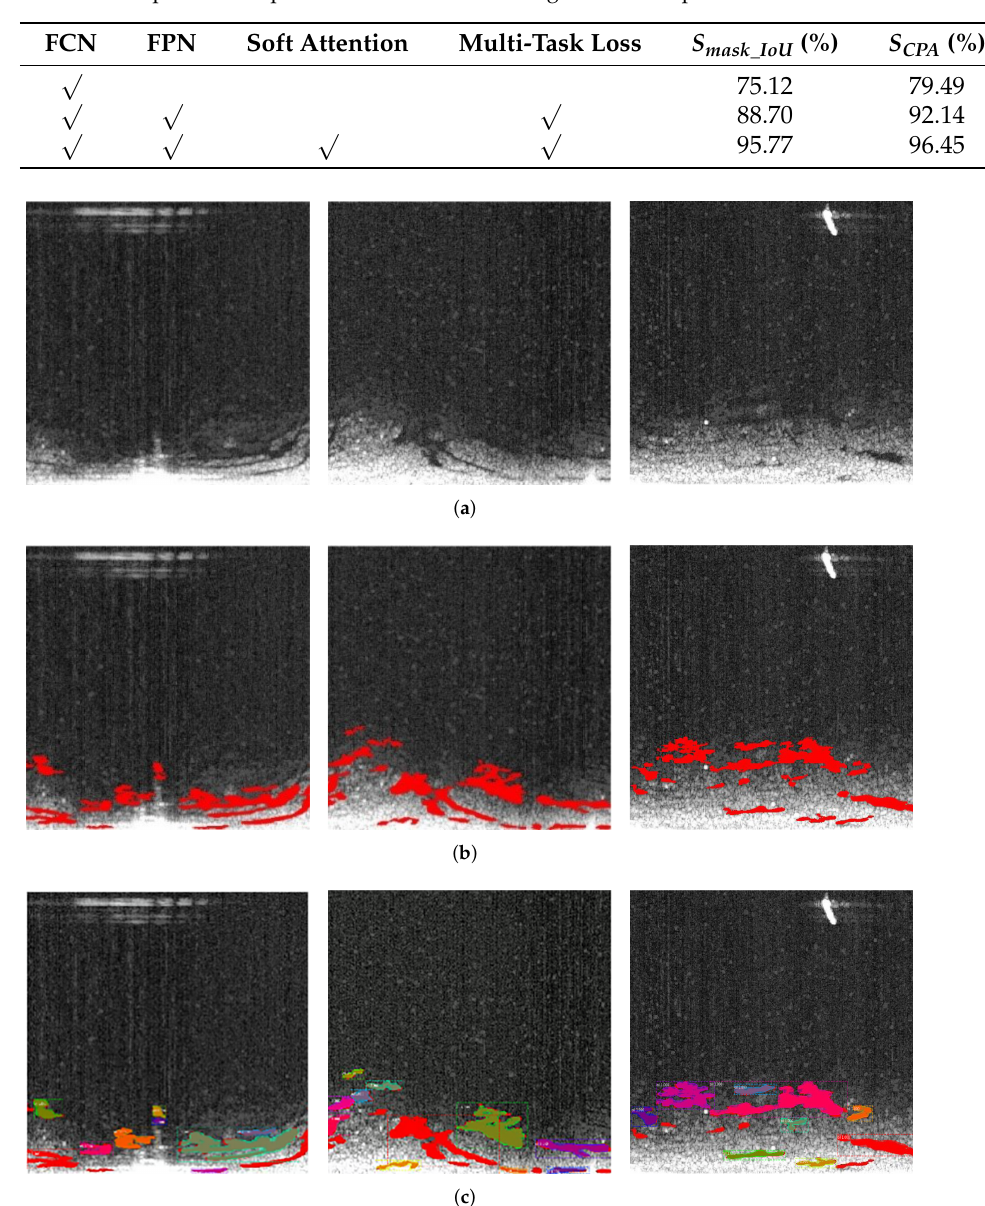
Figure 10. Sea surface oil spill segmentation results. ( a ) The image, ( b ) the ground truth, ( c ) method proposed in this